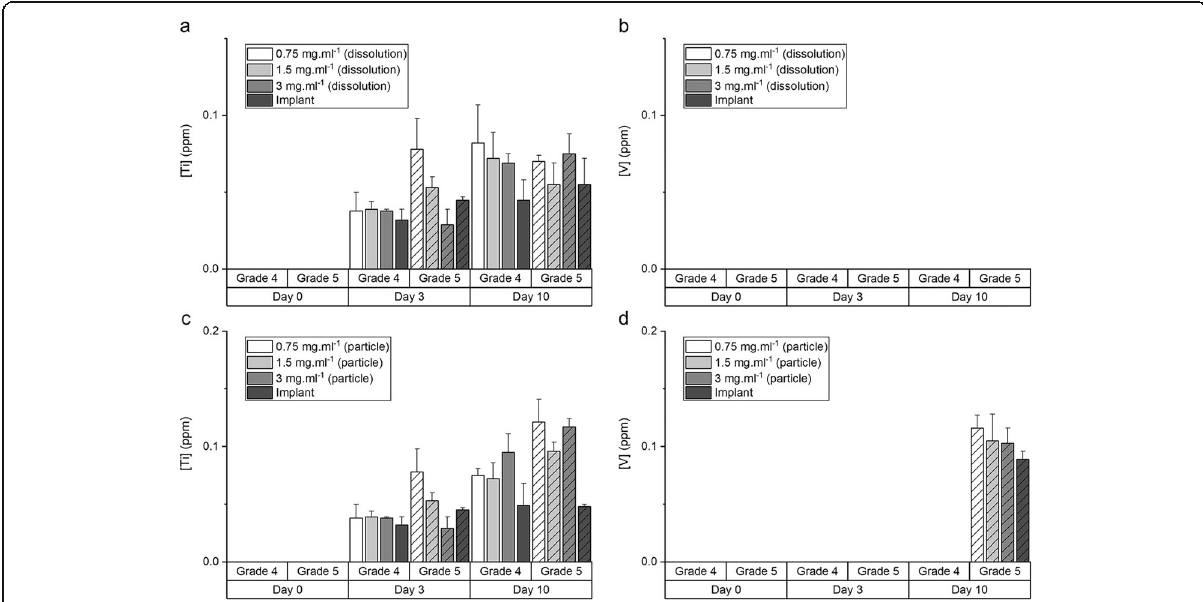
Fig. 4 Titanium (Ti) and vanadium (V) content in Dulbecco ’ s Modified Eagle Medium (DMEM). a , b Dissolution products (media filtered through 0.2 μ m PTFE membrane following initial soaking of the particles for 3 days) and c , d DMEM sampled during cell culture studies where cells were cultured with the particles over a period of 10 days (particles removed prior to ICP measurement). Results presented as mean ± standard deviation, n =